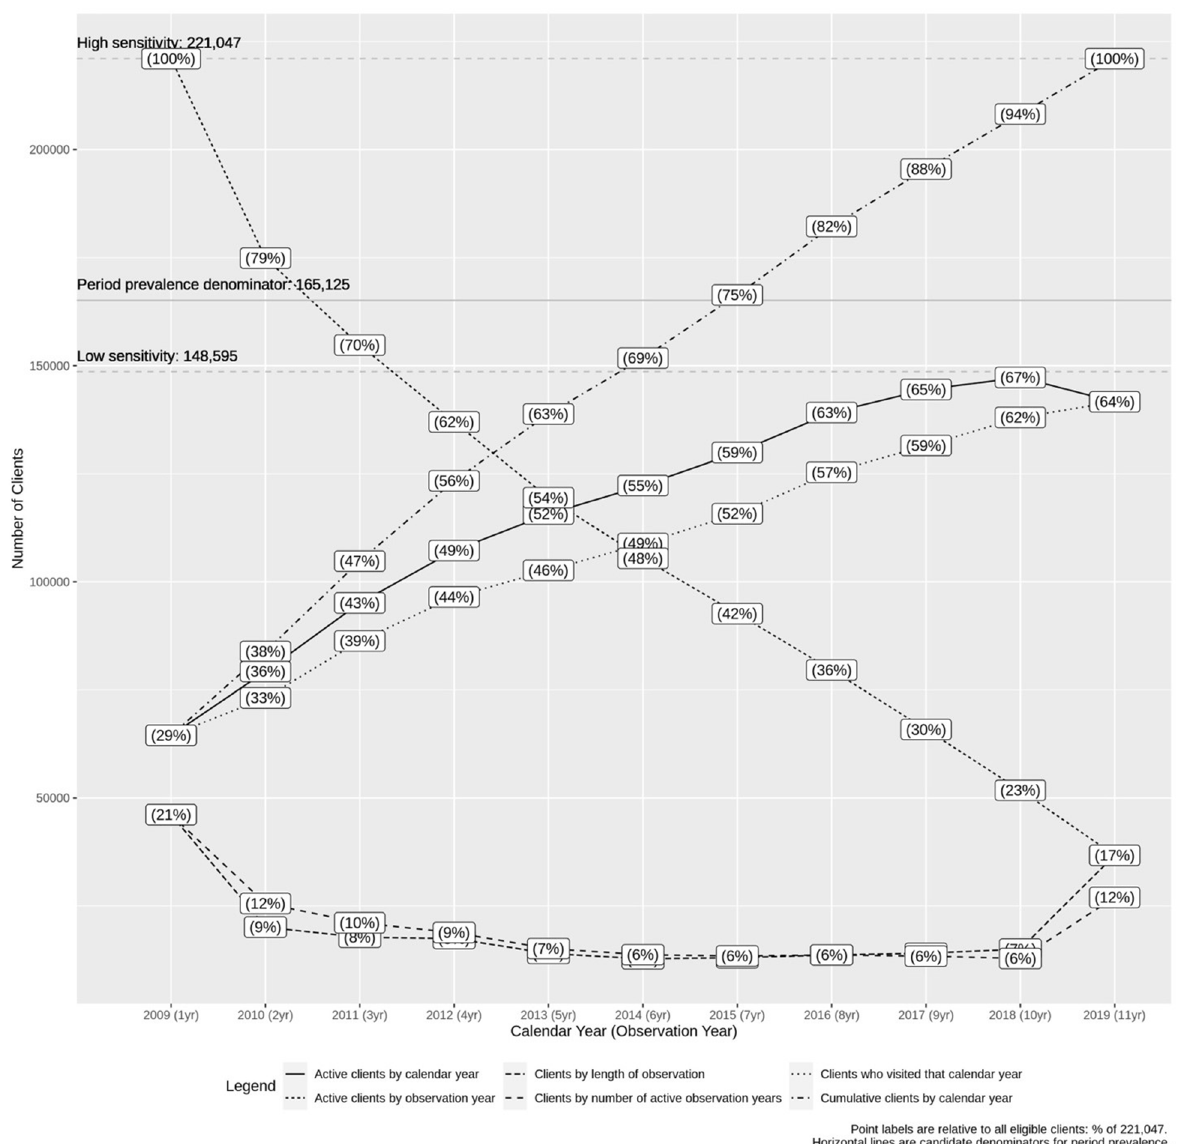
Supplementary Figure 1: Cohort size by calendar- and observation-based